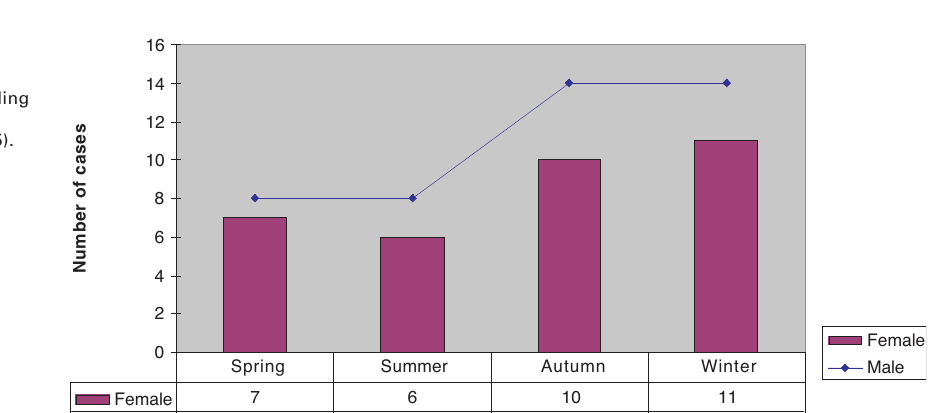
Figure 6 Distribution of AVM cases according to the seasons (p = 0.992; p